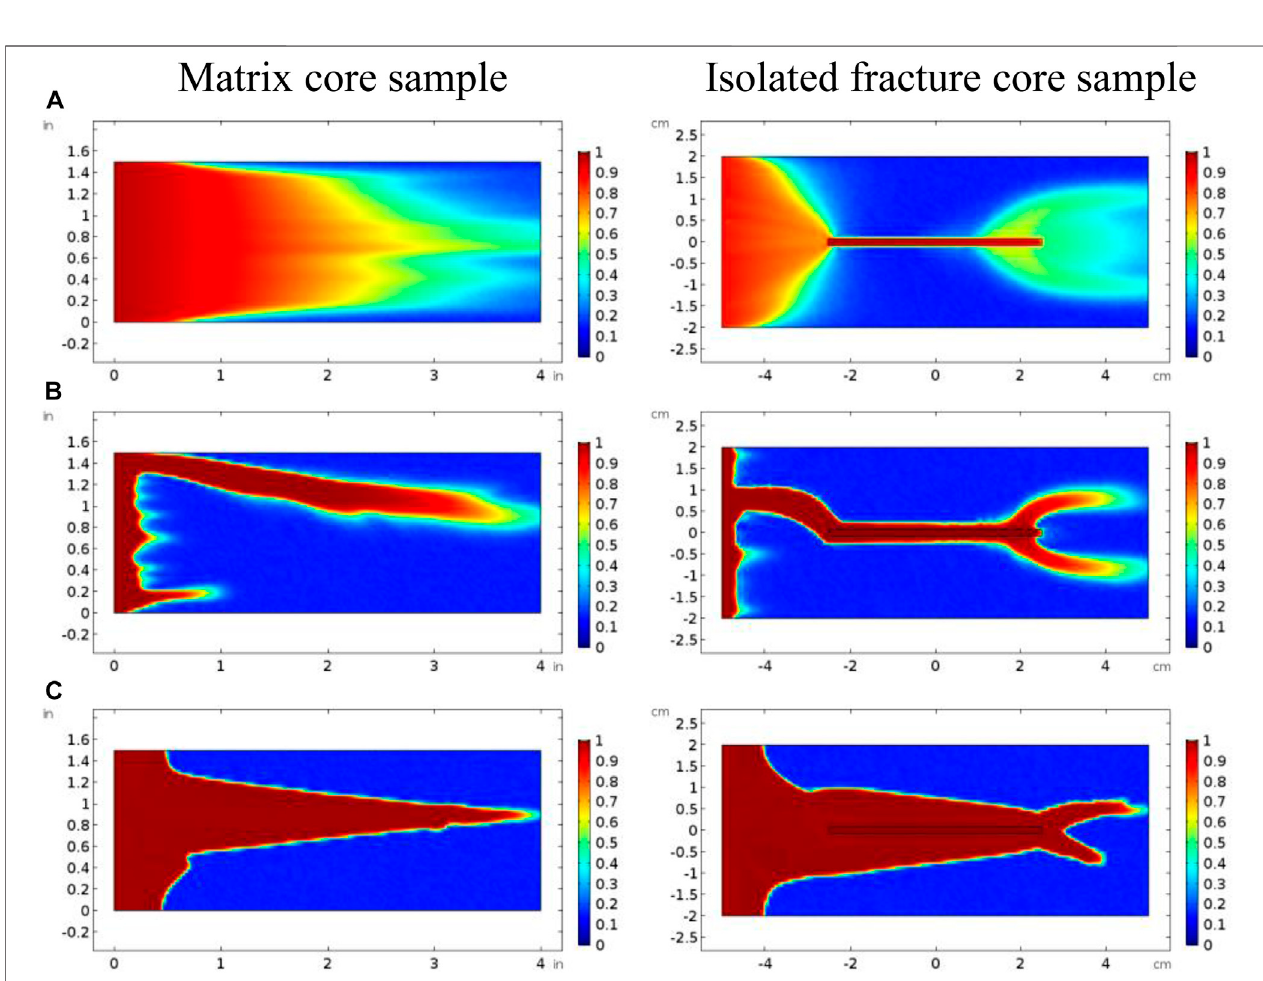
FIGURE 5 | Comparison of dissolution images of matrix and isolated fracture core samples: (A) 0.1 cm/s; (B) 0.01 cm/s; (C) 0.001 cm/s.